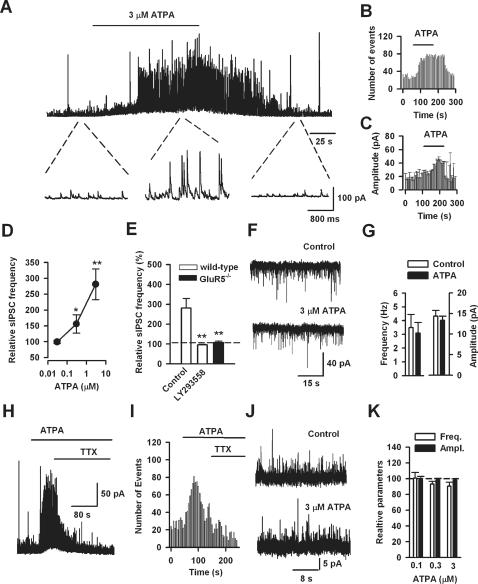
Activation of GluR5 by ATPA reversibly increased sIPSCs but not sEPScs or mIPSCs.(A) A representative example of ATPA (3 µM) modulation of sIPSCs in a BLA pyramidal neuron. The top trace represents sIPSCs recorded before, during and after ATPA application. The bottom 3 traces are presented at an expanded scale. (B and C) Time course for the ATPA-induced enhancement of sIPSC frequency and amplitude in the neuron shown in (A). Note the effect of ATPA is reversible. (D) The facilitatory effect of ATPA on sIPSC frequency is concentration dependent (0.03 µM, n = 6; 0.3 µM, n = 5; 3 µM, n = 7). (E) The effect of ATPA (3 µM) could be blocked by LY293558 (30 µM, n = 4) or in GluR5−/− mice (n = 4), suggesting that the ATPA's action is mediated by GluR5. *Indicates a significant difference from control without treatment of ATPA. (F and G) ATPA (3 µM) had little effect on either frequency or amplitude of sEPSCs (n = 5). (H and I) A representative trace (F) and time course of drug effect (G) showing that TTX (1 µM) fully reversed the enhancement of sIPSC induced by ATPA treatment (3 µM). Similar results were obtained from an additional 4 neurons. (J and K) In the presence of TTX (1 µM), ATPA did not affect either amplitude or frequency of mIPSCs. Three concentrations of ATPA were used and none had significant effects on sIPSC frequency or amplitude (0.1 µM, n = 7; 0.3 µM, n = 6; and 3 µM, n = 7).